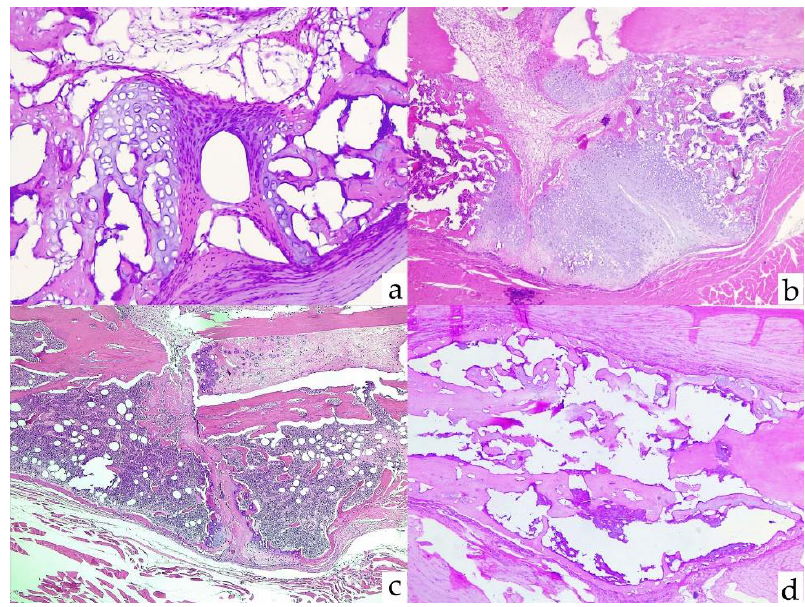
Figure 8. Several examples of histological scores. ( a ) Group A3: absence of consolidation. Allen 1, Huo 1, and Bone Bridge 0. ( b ) Group A2: incomplete consolidation with cartilage between bone fragments. Allen 2, Huo 4, and Bone Bridge 0. ( c ) Group B3: immature bone and cartilage. Allen 5, Huo 8, and Bone Bridge 0. ( d ) Group B2: complete consolidation with bilateral bone bridge. Allen 6, Huo 10, and Bone Bridge 2.